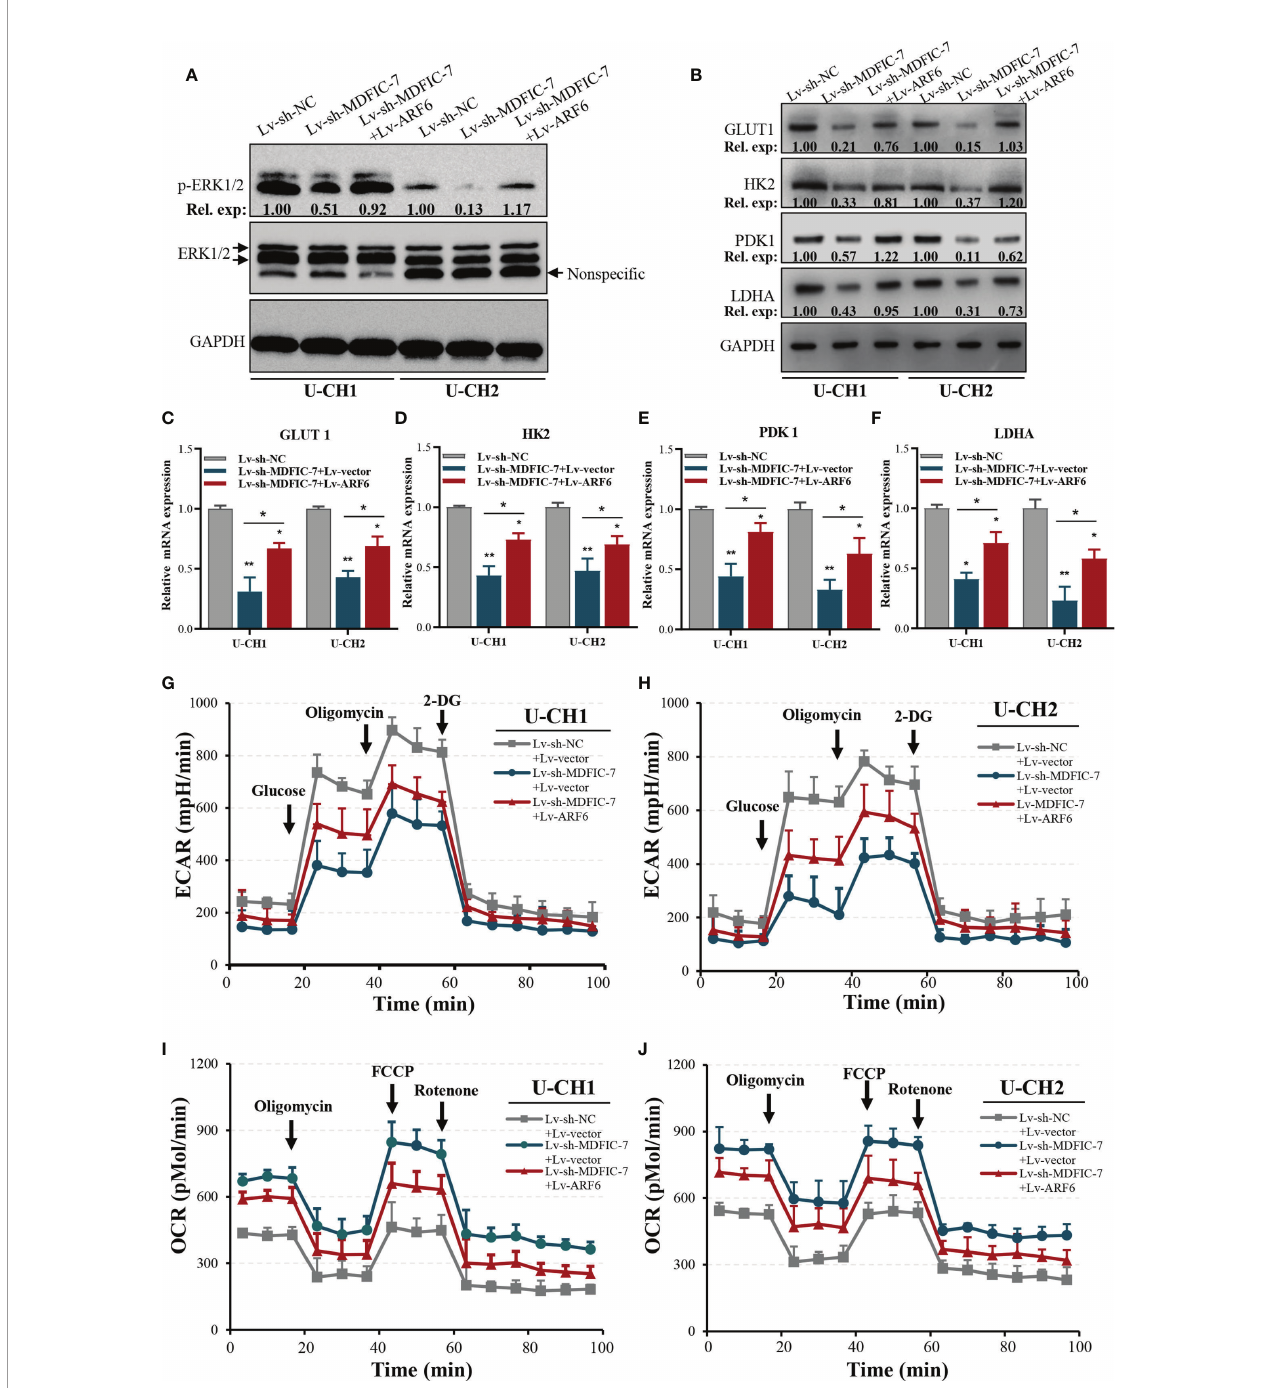
FIGURE 6 | The lncRNA MDFIC-7/miR-525-5p/ARF6 axis regulates aerobic glycolysis of chordoma cells. (A) Western blot analysis of phosphorylated ERK1/2 in cells with lncRNA MDFIC-7 knockdown and ARF6 overexpression. (B) Western blot analysis on aerobic glycolysis – related proteins, including GLUT1, HK2, PDK1 and LDHA, in U-CH1 and U-CH2 cells with lncRNA MDFIC-7 knockdown and ARF6 overexpression. (C – F) qRT-PCR analysis on mRNAs of GLUT1, HK2, PDK1 and LDHA in U-CH1 and U-CH2 cells after infection with Lv-sh-MDFIC-7 or co-infection with Lv-sh-MDFIC-7 and Lv-ARF6, * p < 0.05, ** p < 0.01. (G, H) LncRNA MDFIC-7 knockdown inhibited the glycolytic capacity of U-CH1 and U-CH2 cells, and ARF6 overexpression reversed the inhibitory effect of LncRNA MDFIC-7 knockdown on cancer cell glycolytic capacity, as re fl ected by ECAR analysis. (I, J) LncRNA MDFIC-7 knockdown increased cancer cell mitochondrial respiration in U-CH1 and U-CH2 cells, and ARF6 overexpression reversed the stimulatory effect of LncRNA MDFIC-7 knockdown on cancer cell mitochondrial respiration, as re fl ected by OCR